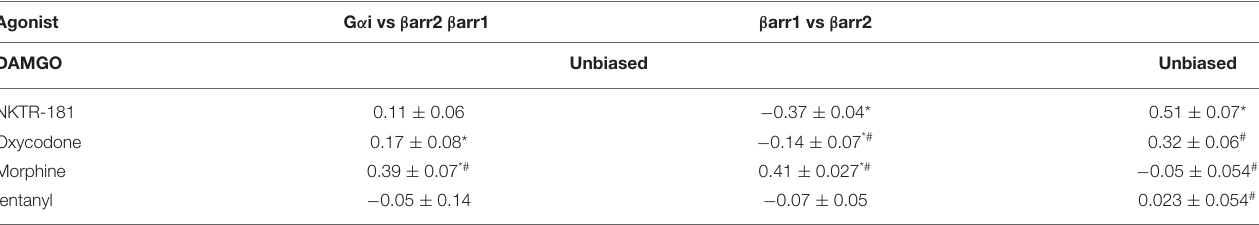
TABLE 3 | G-protein vs. β -arrestin bias: Bias factors were determined using the operational model (based on the ratio of transduction constants σ for each pathway). Agonist